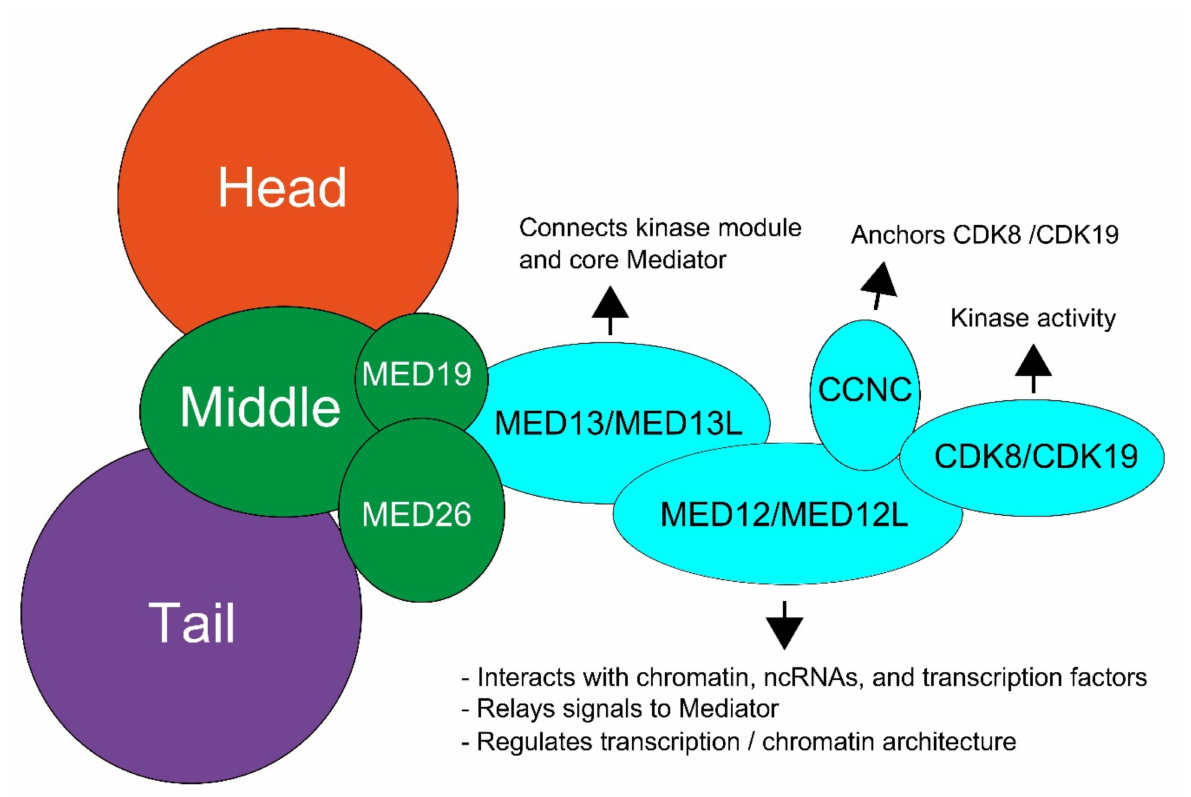
Figure 1. Schematic overview of the structure of the Mediator kinase subunit and the functions of individual proteins. The kinase subunit (light blue) consists of MED13, MED12, Cyclin C (CCNC), and cyclin-dependent kinase 8 (CDK8). Paralogs have been discovered for all subunit components expect CCNC. These paralogs are MED13L, MED12L, and CDK19. Adjusted from Aranda-Orgilles et al.